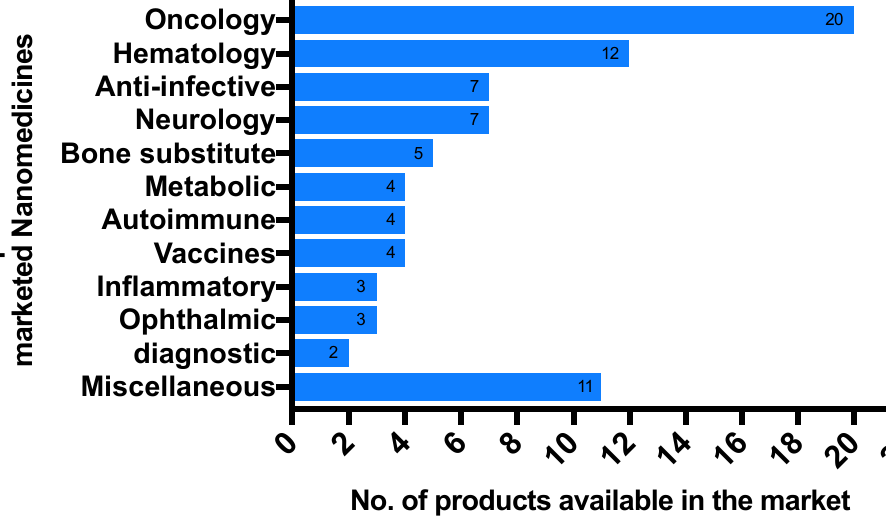
Figure 1. List of globally marketed nanomedicines. Table 2. Selected nanomedicines that are in phase III clinical trials.